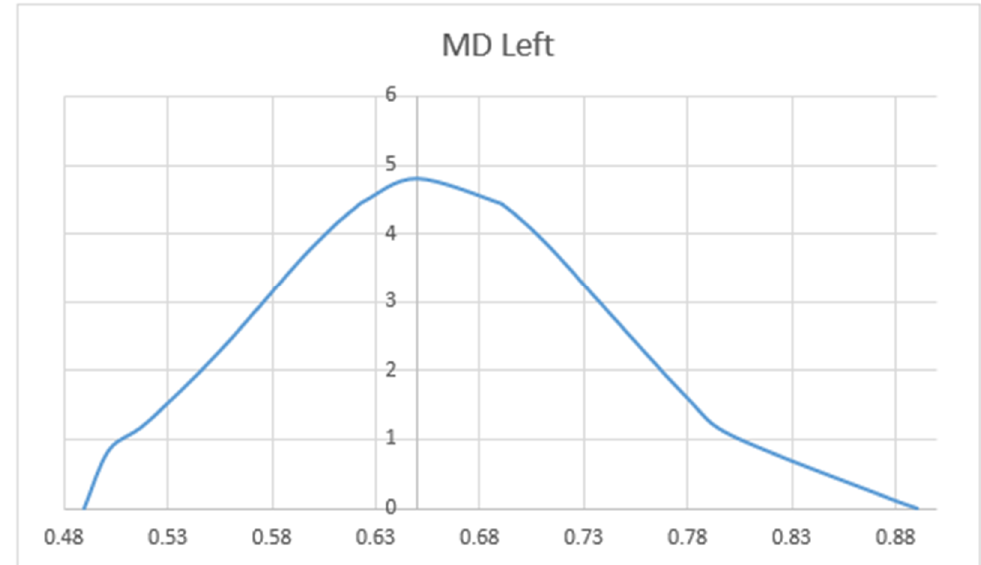
Figure 5. Distribution charts of mean diffusivity (MD) in the left hemisphere of the group of 34 patients aged 25–82.